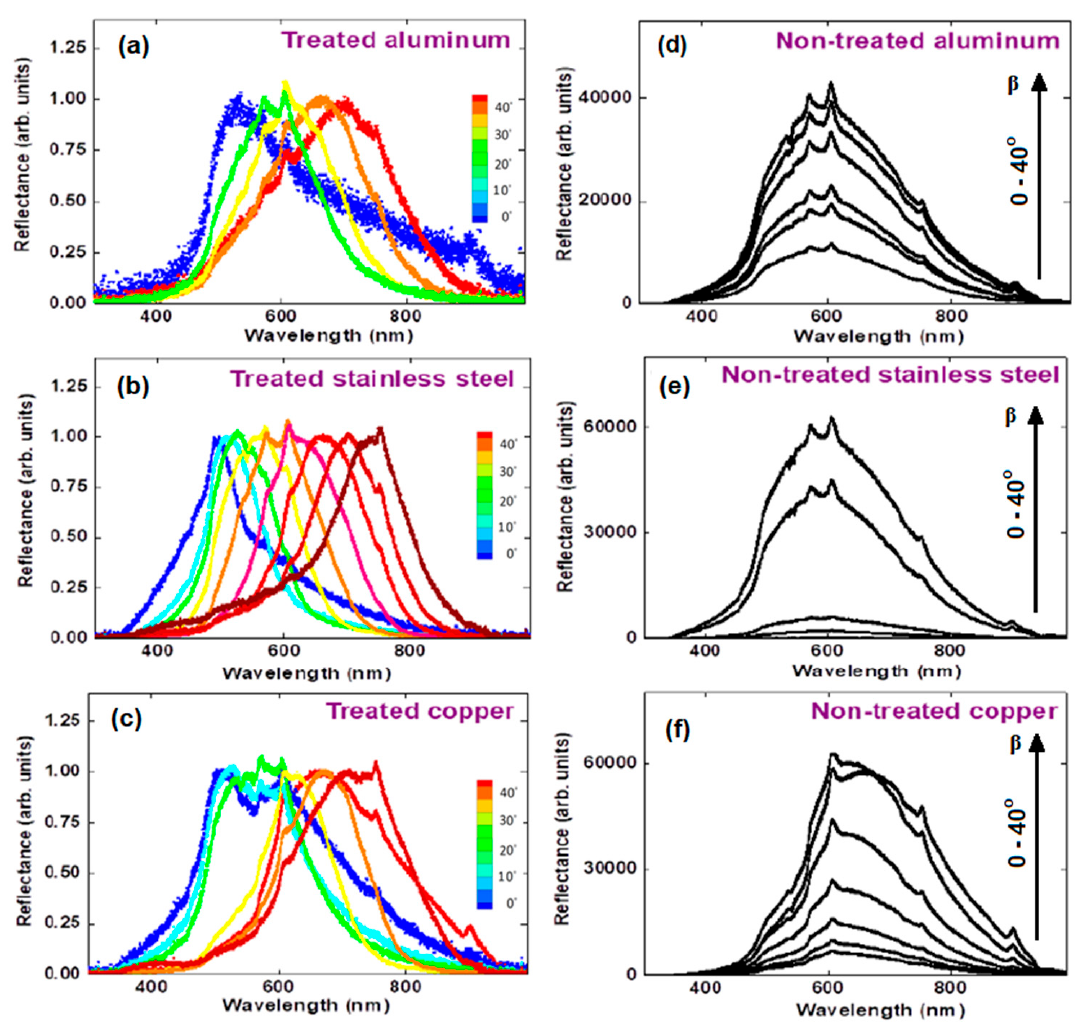
Figure 4. Reflectance spectra from the treated surfaces [( a ) aluminum, ( b ) stainless steel, ( c ) copper] and non-treated surfaces [( d ) aluminum, ( e ) stainless steel, ( f ) copper]. Different curves on each graph correspond to different angles of observation. One can see that, in the case of non-treated surfaces, the reflectance spectra remain the same at different angles of observation, contrary to the case of treated surfaces. The colors in ( a – c ) correspond to the colors viewable by eye at the corresponding angles. The angle ( β ) ranged from 0° to 40°, where 0° corresponds to the position of the spectrometer when it is perpendicular to the sample. As β increased, longer wavelengths were detected.